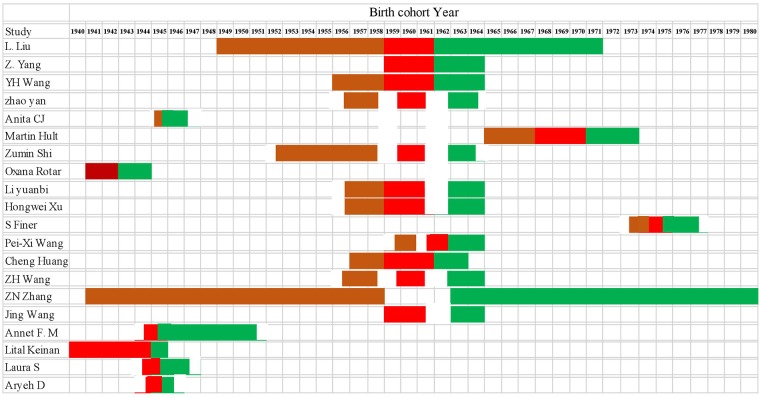
All studies grouping in the famine exposure.Red: fetal exposed, Brown: childhood exposed, Green: nonexposed.